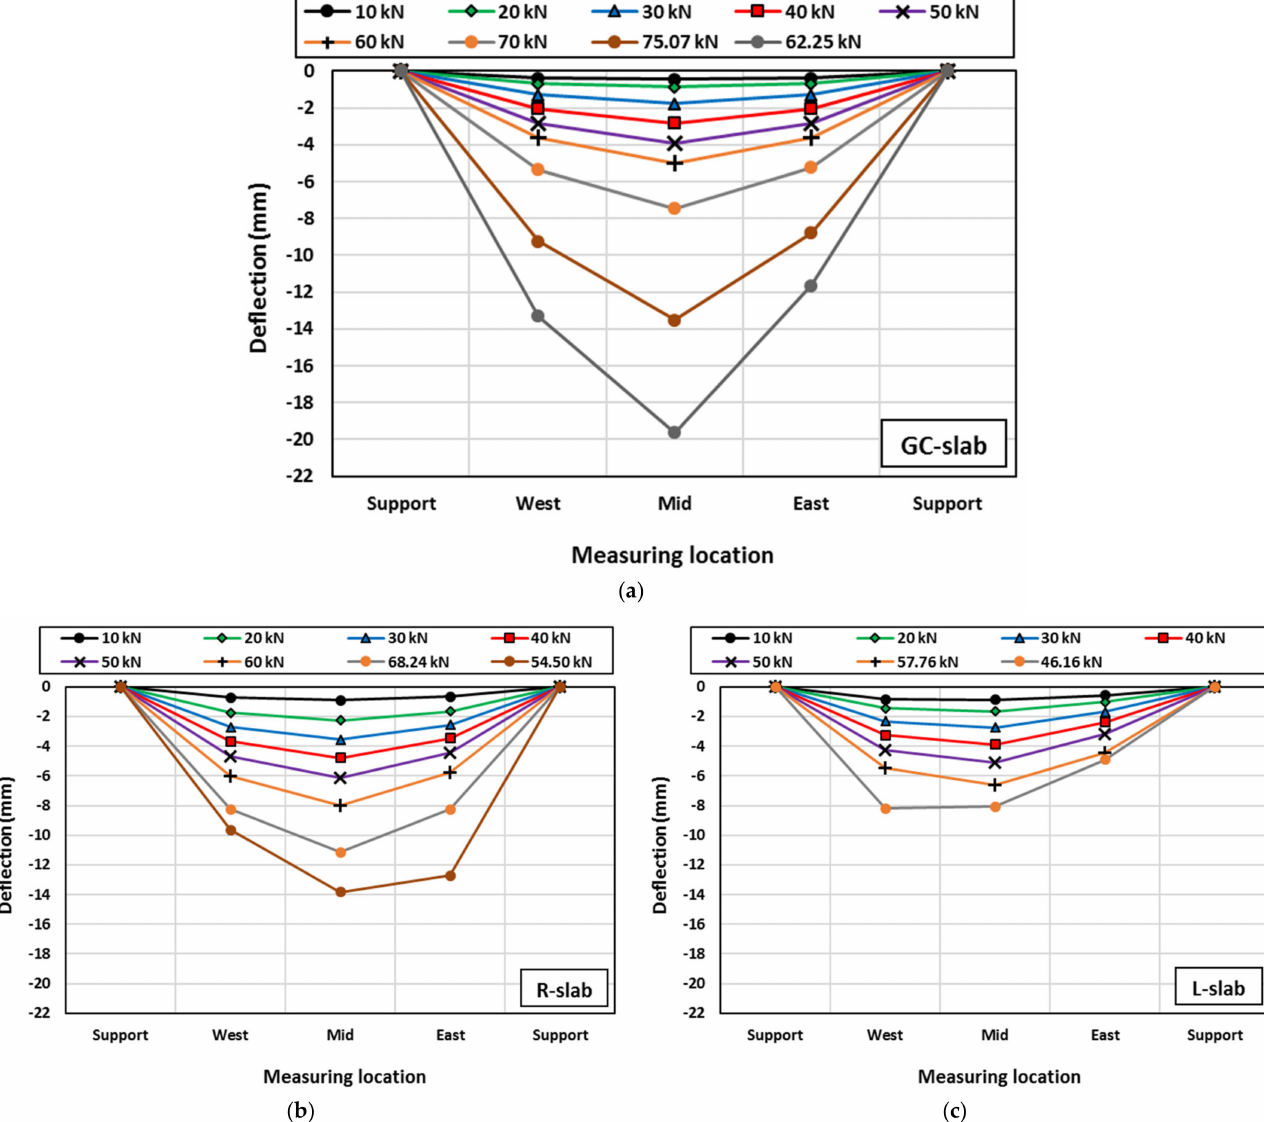
Figure 16. Deflection distribution at each 10 kN for: ( a ) GC-slab, ( b ) R-slab, and ( c )